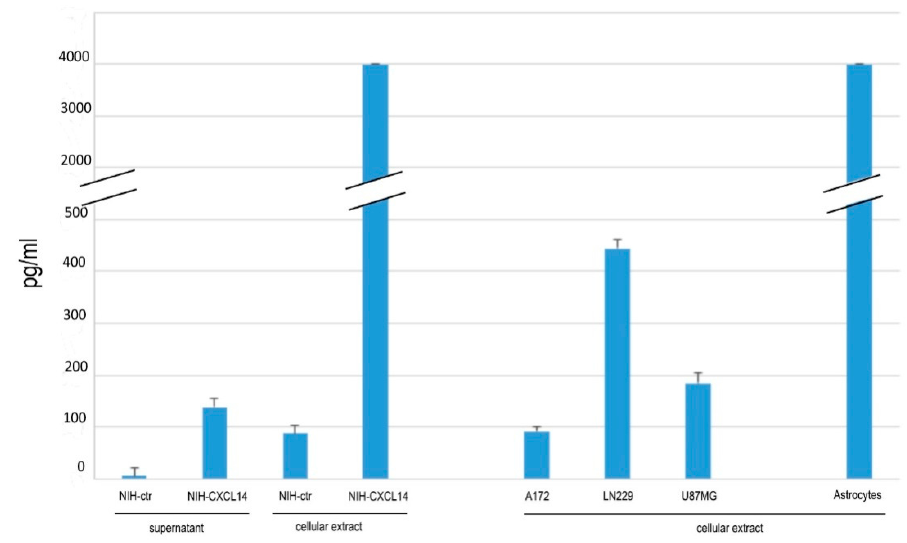
Figure 1. CXCL14 protein expression and secretion. Measurement of CXCL14 protein levels by ELISA in cell protein extracts of cultured human astrocytes, three human glioblastoma cell lines (A172, LN229, U87MG), and in protein extracts and conditioned media of NIH-ctr and NIH-CXCL14 fibroblasts. Results are shown as the mean ± S.D. and represent the average of three biological replicates per sample.